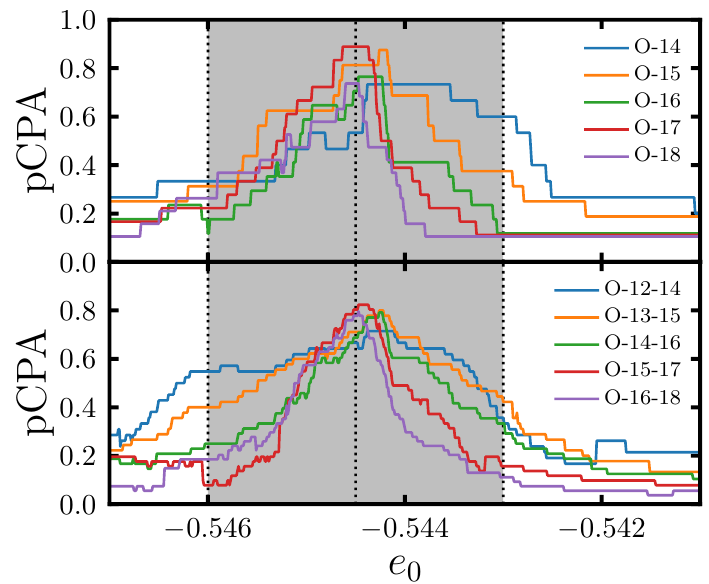
Figure 2: Proportion of coinciding Padé approximants (pCPA) as a function of the ground-state energy for several orders n (top panel) and also taking groups of 3 orders (bottom panel). The grey area denotes the value from exact diagonalization = − 0.5445 ( 15 ) [ 8 ] . along with its error bars, e 0